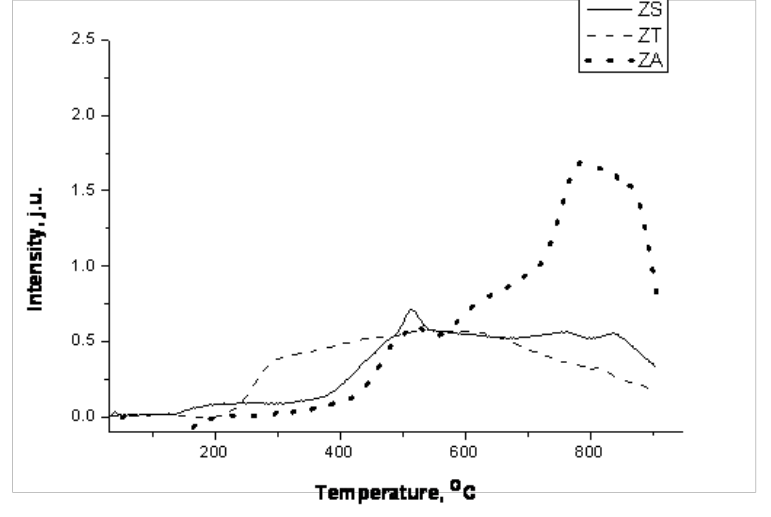
Figure 3. TPRH 2 profiles of ZT, ZS and ZA